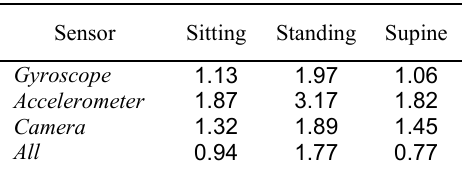
Table 2. Respiration Rate Estimation